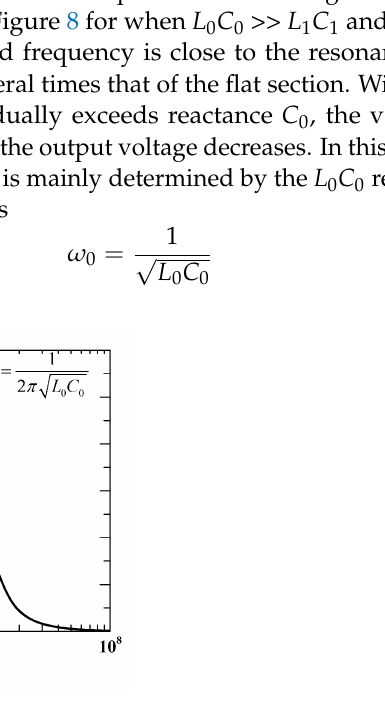
Figure 8. Amplitude – frequency characteristics of the voltage divider when L 0 C 0 >> L 1 C 1 and L 2 C